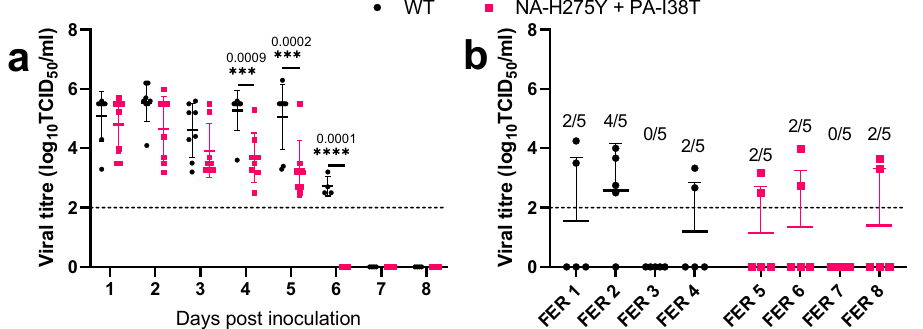
Fig. 2 Viral shedding and lung lobe viral load of WT and NA-H275Y + PA-I38T virus isolate infected ferrets. Ferrets ( n = 8) infected by the intranasal route with 4 log 10 TCID 50 /mL (in 500 µ L of PBS) with WT (d1 isolate, black) or NA-H275Y + PA-I38T (d10 isolate, red) puri fi ed virus isolates were nasally washed daily for 9 days. Half of the ferrets were culled at day fi ve post-inoculation to harvest the fi ve major lung lobes. a The viral shedding from the ferret nasal washes was measured by TCID 50 assay. b Viral titre of each homogenised lung lobe aliquot wase enumerated using a TCID 50 assay, the fraction representing the number of major lung lobes with detectable viral titres (above LOD) per ferret. Each dot represents the titre in a single lung lobe and the line shows the mean. Error bars represent one SD. LOD is shown as a dotted horizontal line, all values beyond LOD equal zero viral titre. Adjusted p -values and asterisks show statistically signi fi cant ( p < 0.05) differences (Two-way ANOVA with Sidak ’ s multiple of each virus when assessed at a high or low MOI, although the PA-I38T single mutant appeared to have a slightly delayed replication in the single-stage experiment (Fig. 1). Pyrosequen- cing analysis also con fi rmed that each virus maintained (at 95- 100%) their relevant substitution at AA positions, NA-275 and PA-38, at 102 h post infection, indicating none of the mutants had reverted to the WT genotype (Supplementary Table 3).